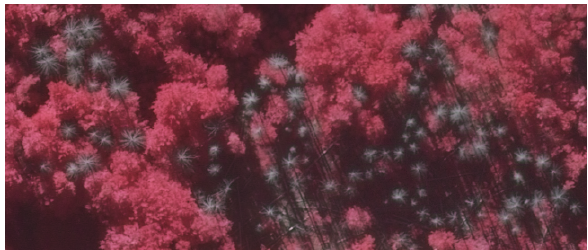
Figure 4. Color infrared image of Plot 3. Shades of red indi- cate European beech trees, gray hues show standing dead Norway spruce